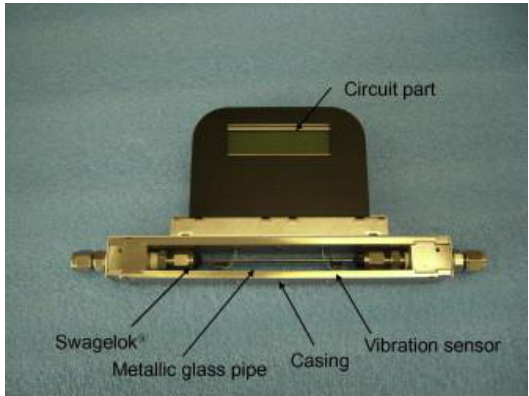
Figure 18. An outer appearance of the self-made Coriolis flow meter using the Ti–Cu–Ni–Zr–Sn BMG pipe. Reproduced with permission from [232]. Copyright 2011, Elsevier.